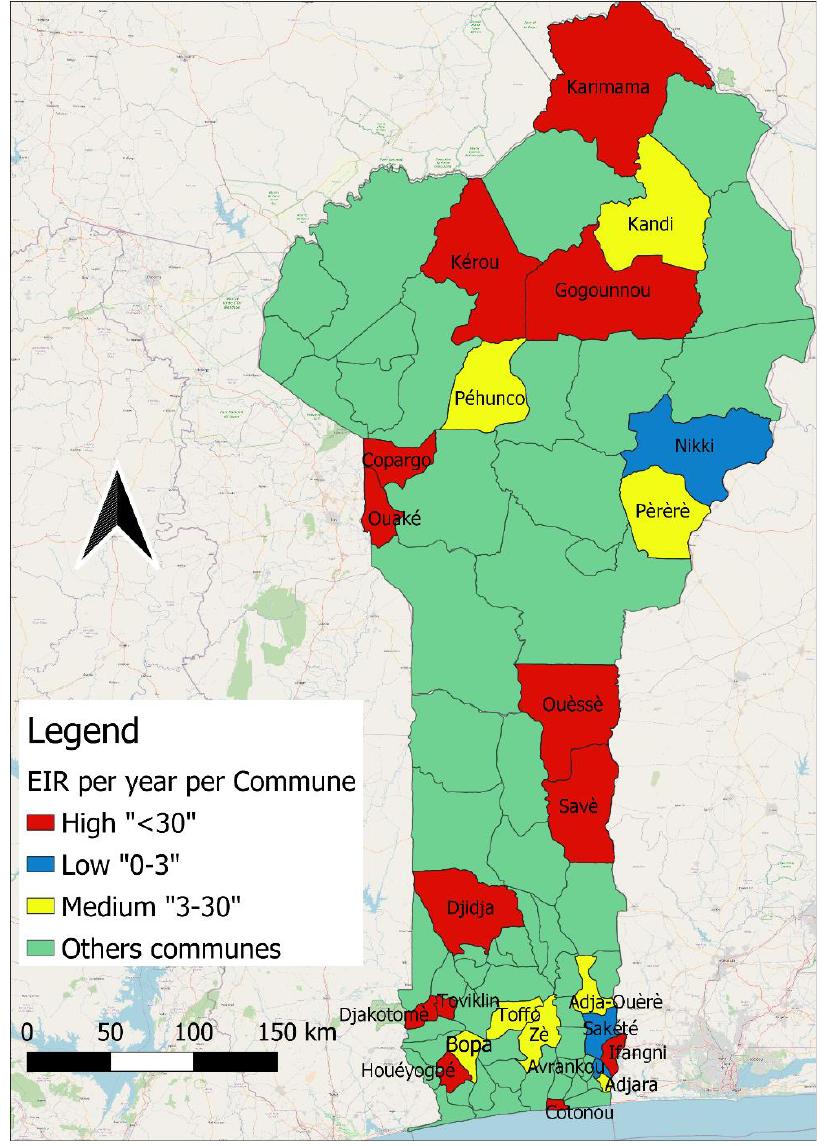
Figure 4. Map of the EIR (infectious bites per person per year) for sampled Communes. 3.7. Parity rate of An. gambiae s.l., An. funestus Group and An. nili Group The average parity rate was 78.6% (840 parous vectors out of 1069 dissected females) with moderate variation between departments. Parity rate was highest in Collines depart- ment (95.1%) (Figure 5) and lowest in Borgou department (52.1%; p < 0.05).